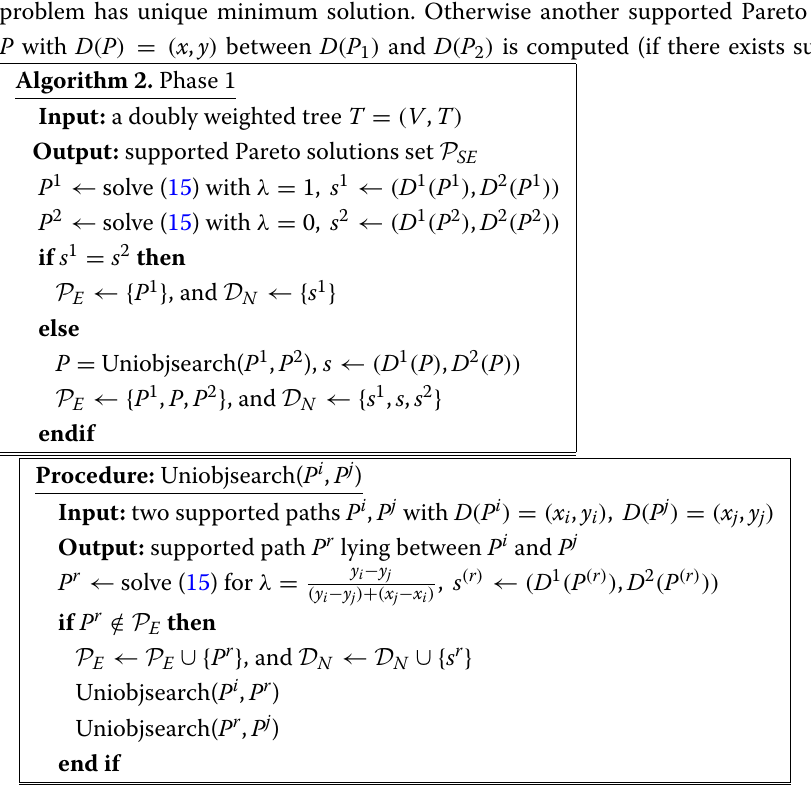
Algorithm 2. Phase